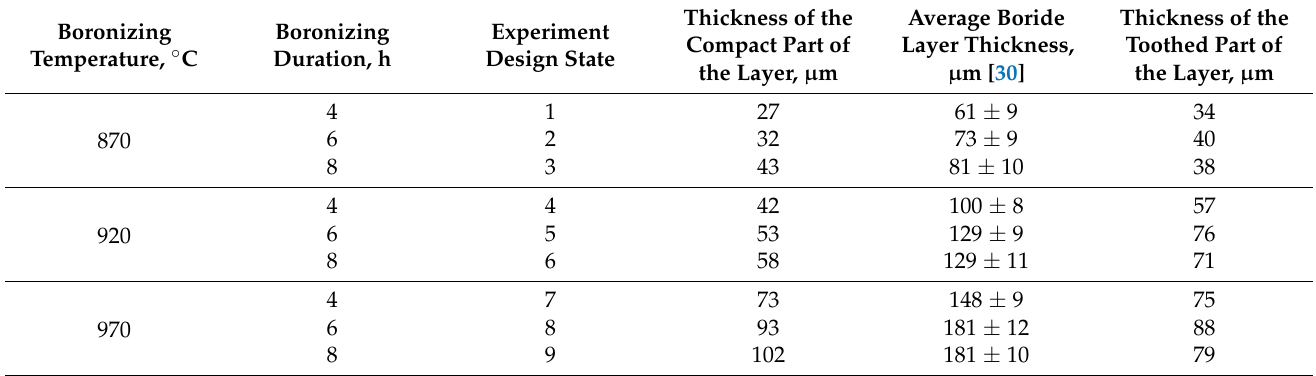
The dependence of the thickness of the compact and toothed parts of the layer on the temper- ature and the duration of boronizing is shown in the diagrams in Figures 6 and 7, respectively.